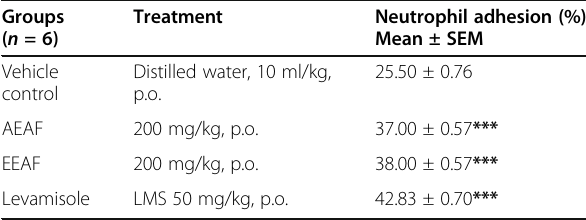
Table 9 Effect of aqueous and ethanolic extract of A . ficulneus L. leaves on neutrophil adhesion in